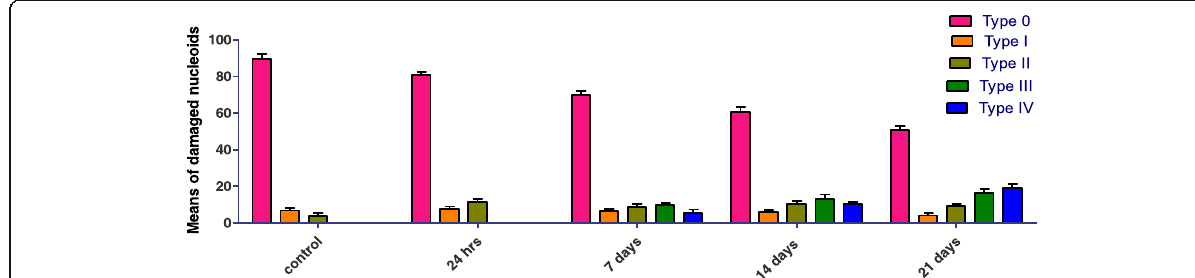
Fig. 9 Graph representing nucleoids in various degrees of damage (mean ± S.D.) in the blood of C. carpio during sub-lethal exposure to karanjin